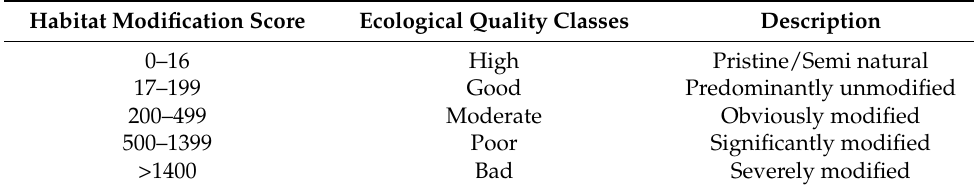
Table 2. Habitat Modification Classes according to HMS and their correspondence with ecological quality classes according to